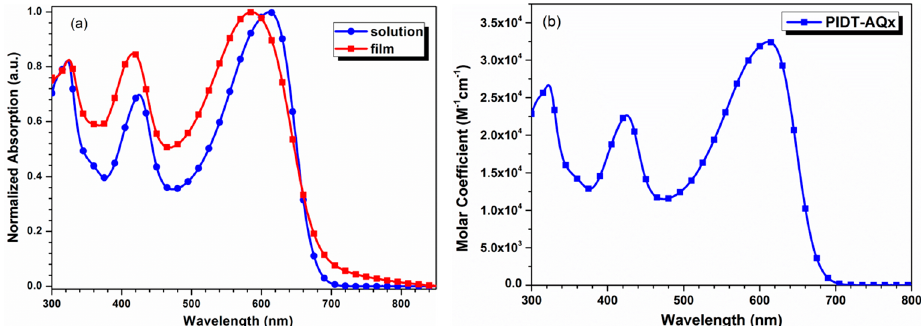
Figure 2. Normalized absorption spectra of PIDT-AQx in chloroform solution and thin film state ( a ) and the molar coefficient of PIDT-AQx in chloroform solution (10 − 6 M) ( b ).